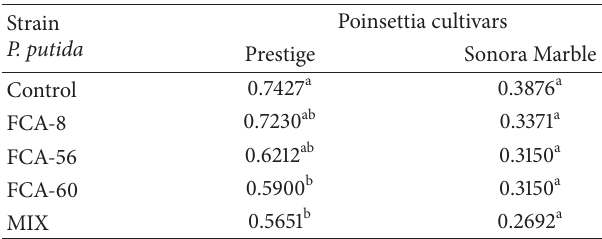
Table 3: Effects of Pseudomonas putida strains on the anthocyanin pigment contents of the bracts of poinsettia plants.